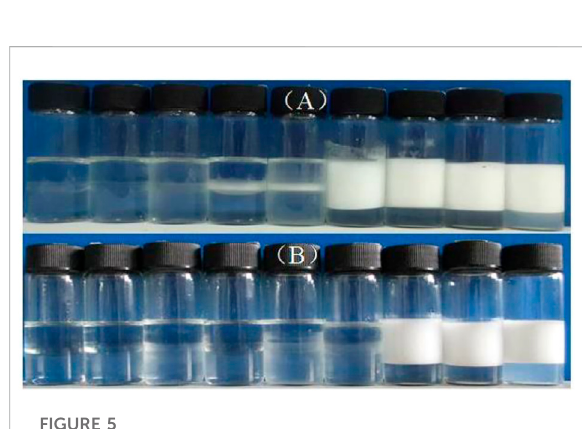
FIGURE 5 Photographs of toluene-in-water emulsions stabilized by SDSaloneatdifferentconcentration,taken (A) 24 hand (B) 1 week afterpreparation.ConcentrationofSDS(fromlefttoright):3×10 − 5